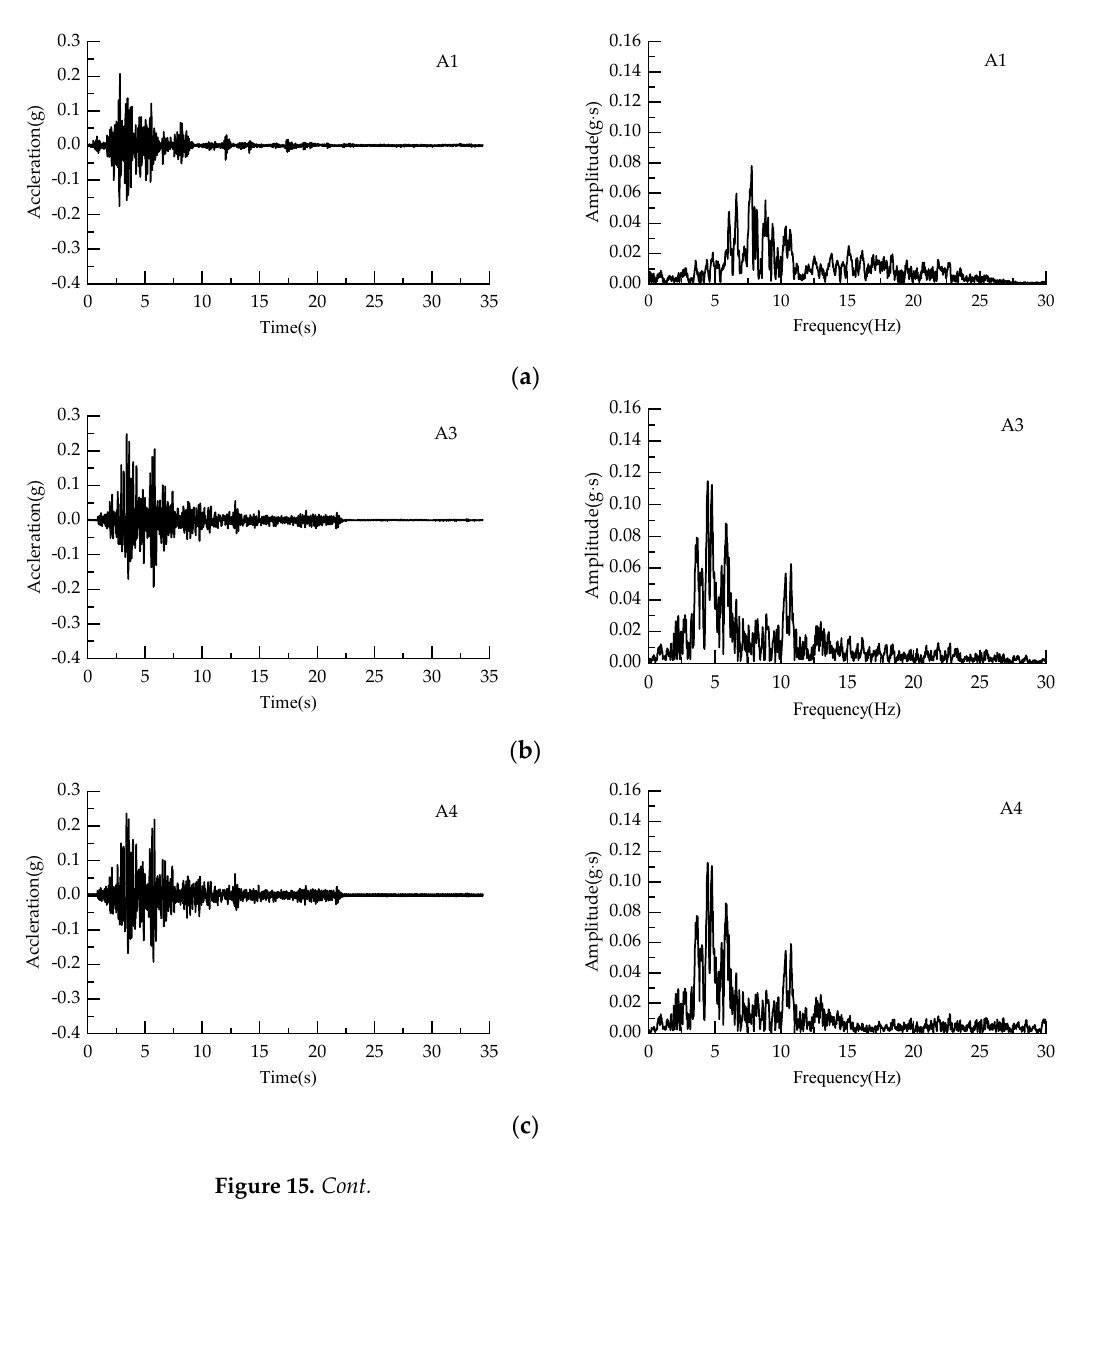
Figure 15. Acceleration records and Fourier spectra of monitoring positions in the shaking table tests. ( a ) Acceleration time history and Fourier spectrum of monitoring point A1; ( b ) acceleration time history and Fourier spectrum of monitoring point A3; ( c ) acceleration time history and Fourier spectrum of monitoring point A4; ( d ) acceleration time history and Fourier spectrum of monitoring point A5.